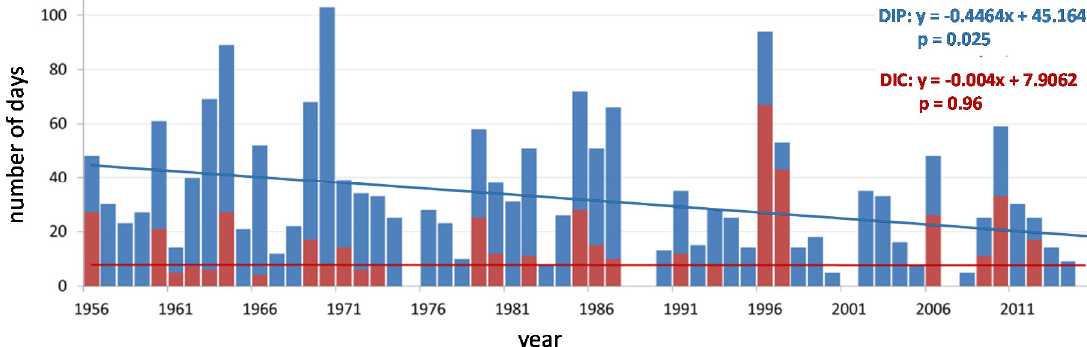
Figure 10. Duration of ice phenomena (DIP) in days (blue) and duration of ice cover (DIC) in days (red) on the Oder River at Słubice with their rates of change (1956–2015) (based on data from the Institute of Meteorology and Water Management—National Research Institute in Warsaw).